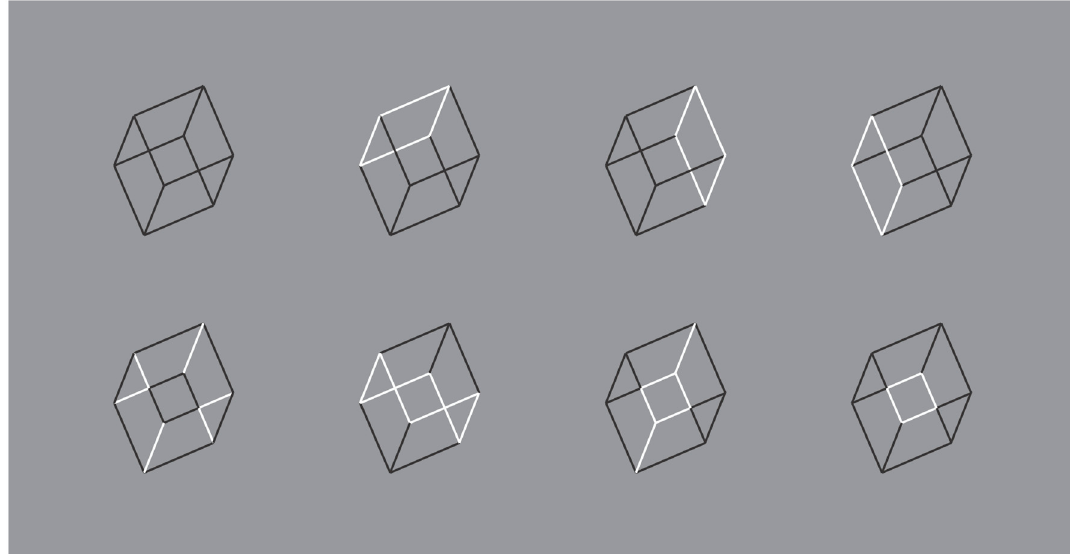
Figure 13. Different views of the Necker cube (first row) and weakened, disrupted, camouflaged, and invisible cube (second row).